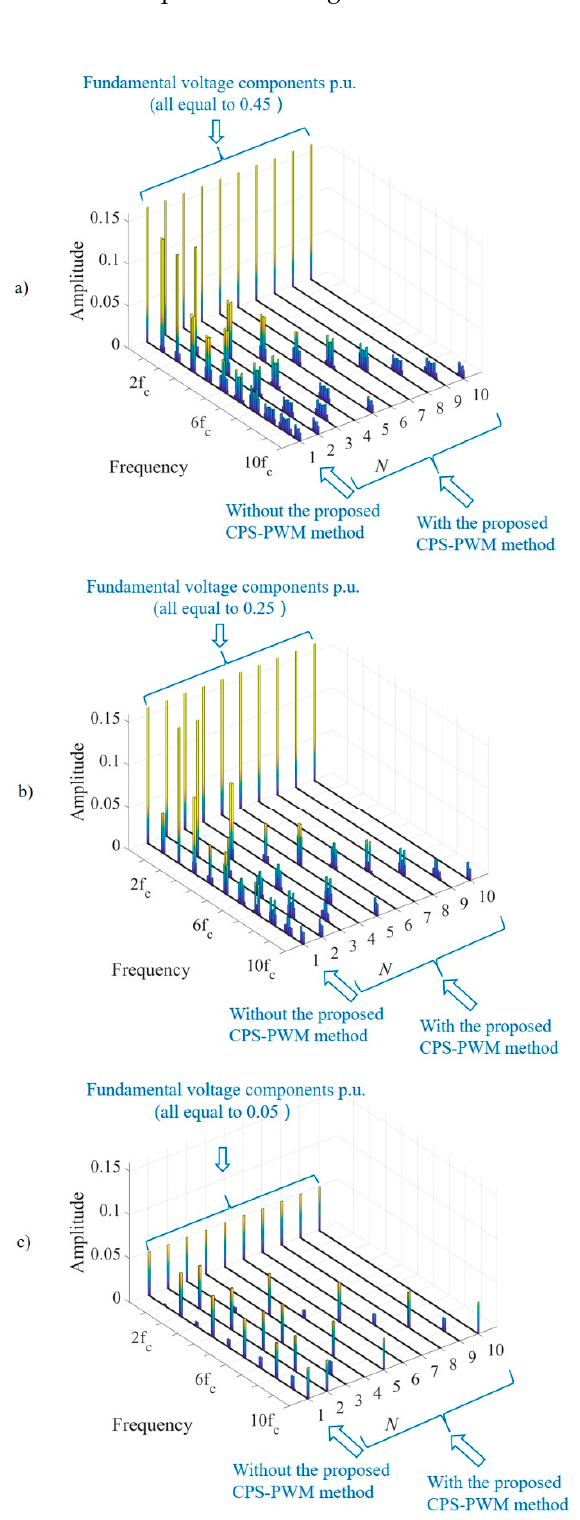
Figure3. Multithree-phasedriveFFTspectrawithandwithouttheproposedphase-shiftedcarrier-based pulse-width modulation (CPWM) under di ff erent M . ( a ) M = 0.9, ( b ) M = 0.5, ( c ) M = Figure 3. Multi three-phase drive FFT spectra with and without the proposed phase-shifted carrier- based pulse-width modulation (CPWM) under different 𝑀 . ( a ) 𝑀 = 0.9 , ( b ) 𝑀 = 0.5 , ( c ) 𝑀 = 0.1 .